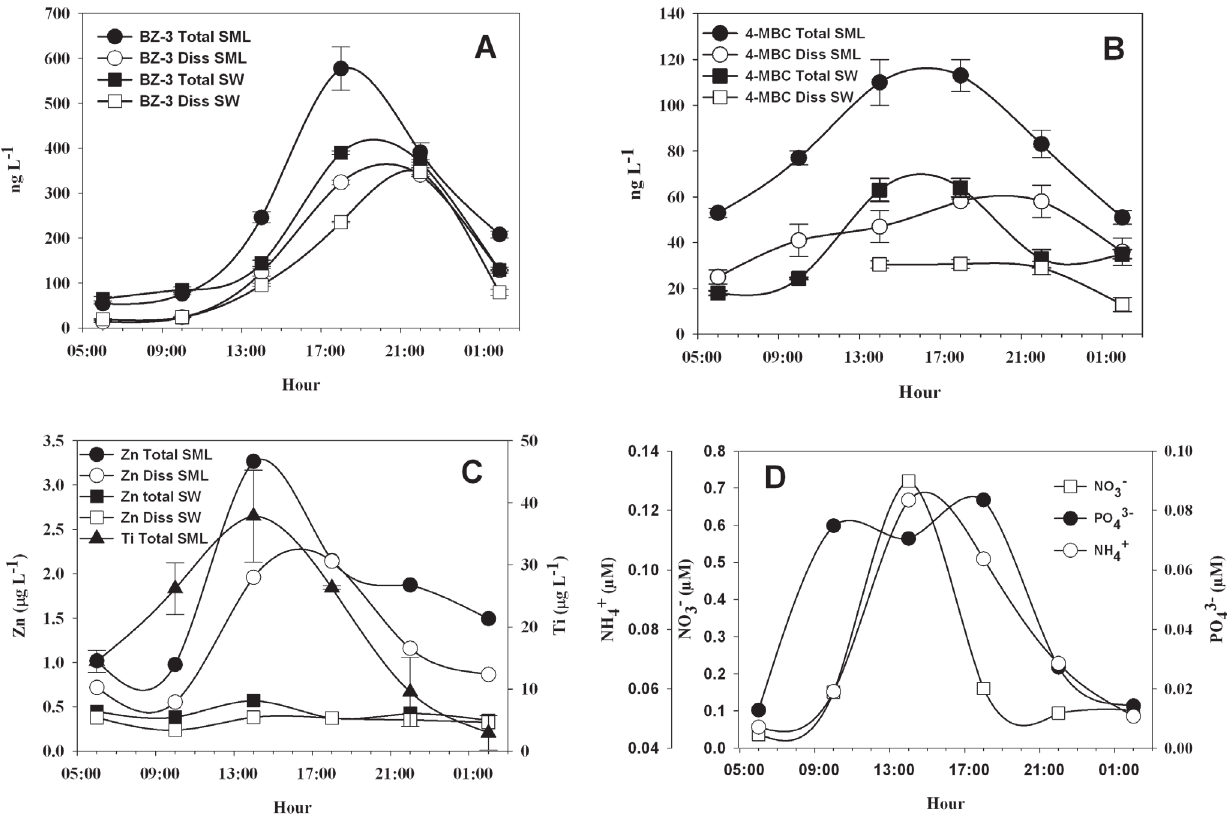
Figure 3. Kinetics of nutrient release from a commercial sunscreen in seawater (n=3). NO 2- was not detected.